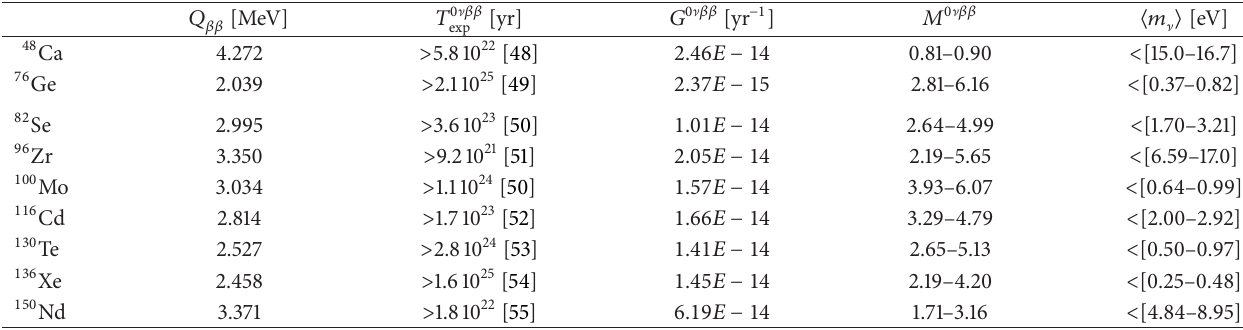
Table 2: Majorana neutrino mass parameters together with the other components of the 0 ] 𝛽𝛽 decay halftimes: the 𝑄 𝛽𝛽 values, the experimental lifetime limits, the phase space factors, and the nuclear matrix